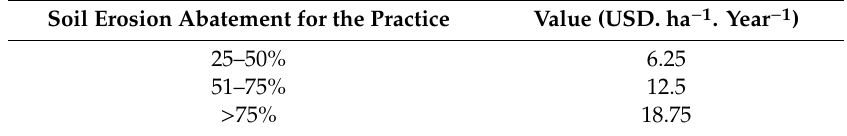
Table A3. Values for payment for ecosystem services to landowners for soil conservation practices in